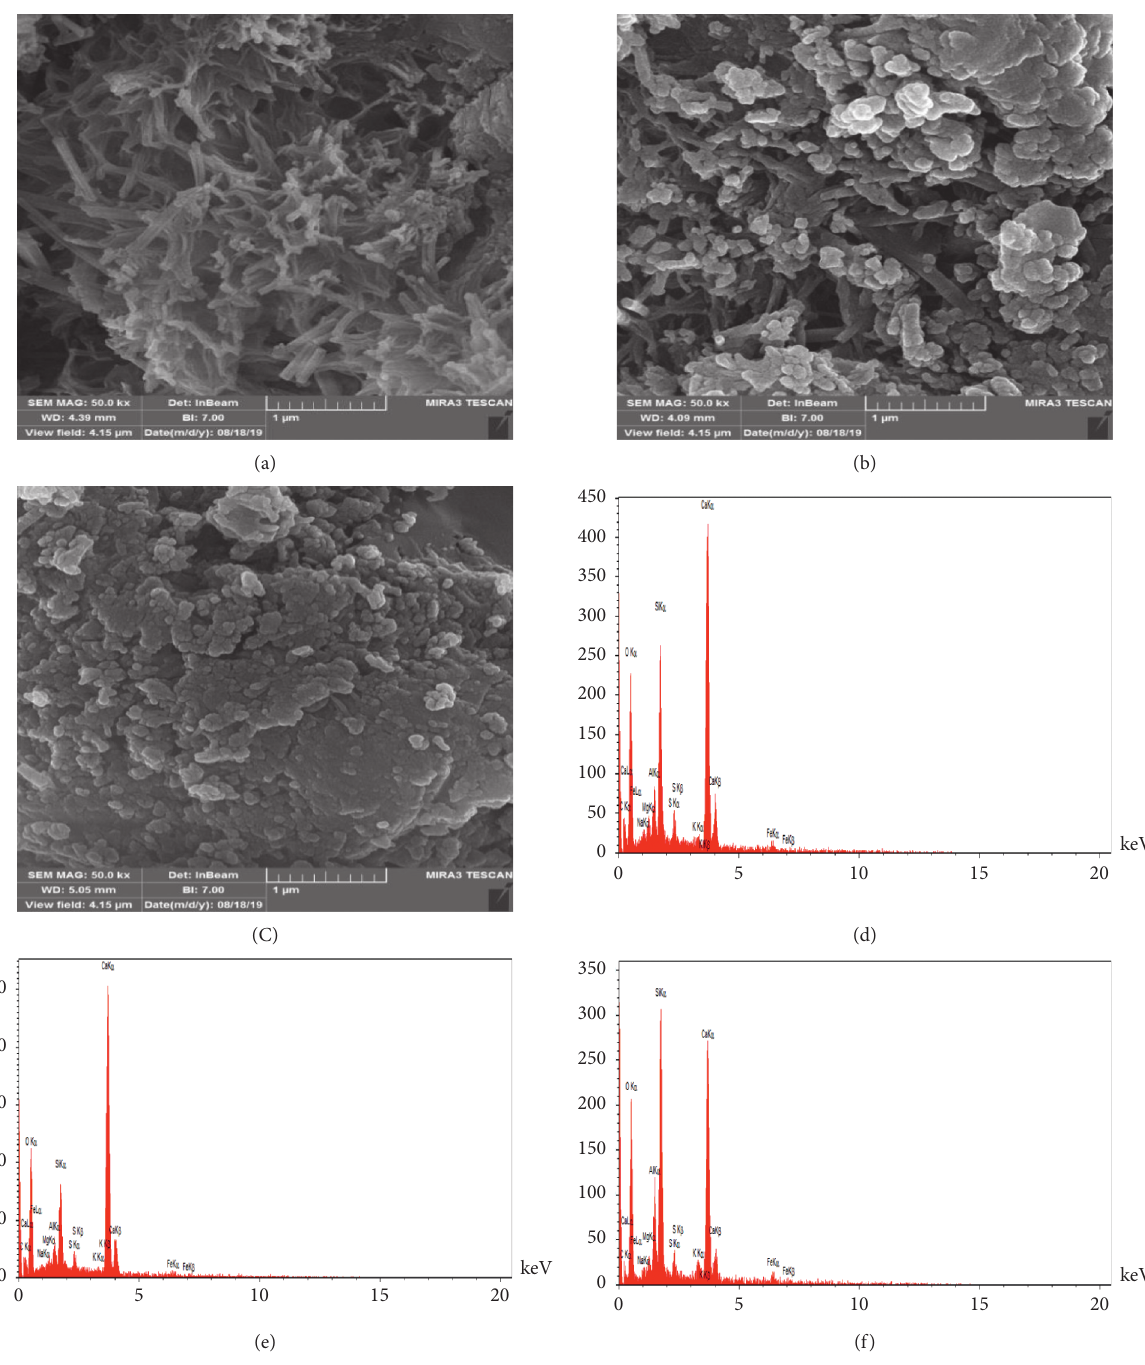
Figure 15: Spectrum of (a) SEM of the control sample, (b) concrete containing 2% Al Al 2 O 3 nanoparticles; (d) EDX of the control sample, (e) concrete containing 2% Al 2 O 3 nanoparticles, and (f) concrete containing 2% GO/ Al 2 O 3